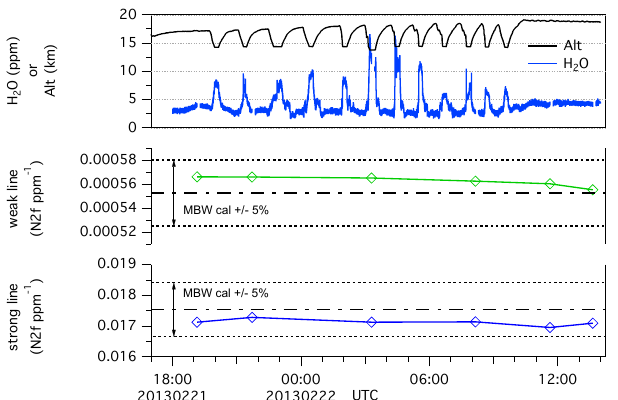
Figure 10. WV channel sensitivity measured during in-flight cal- ibrations from a flight on 21–22 February 2013. Top panel: water vapor mixing ratios and aircraft altitude during a series of profiles through the TTL. Middle panel: calibration slopes (sensitivity) for the weaker absorption line (3711.9cm − 1 ) . Bottom panel: calibra- tion slopes for the strong H 2 O absorption line (3712.2cm − 1 ) . Each data point represents a calibration procedure in which dry synthetic air displaced the ambient flow for 8.7min and a series of 8 H 2 O mixing ratios between 2 and 400ppm were added in time intervals of 40–60s. In the middle and bottom panels, the dash-dot horizon- tal lines indicate the sensitivity measured in the laboratory prior to the flight. The dotted lines indicate the ± 5% range surrounding the pre-flight laboratory value. The solid lines simply connect the data points as an aid to the reader.